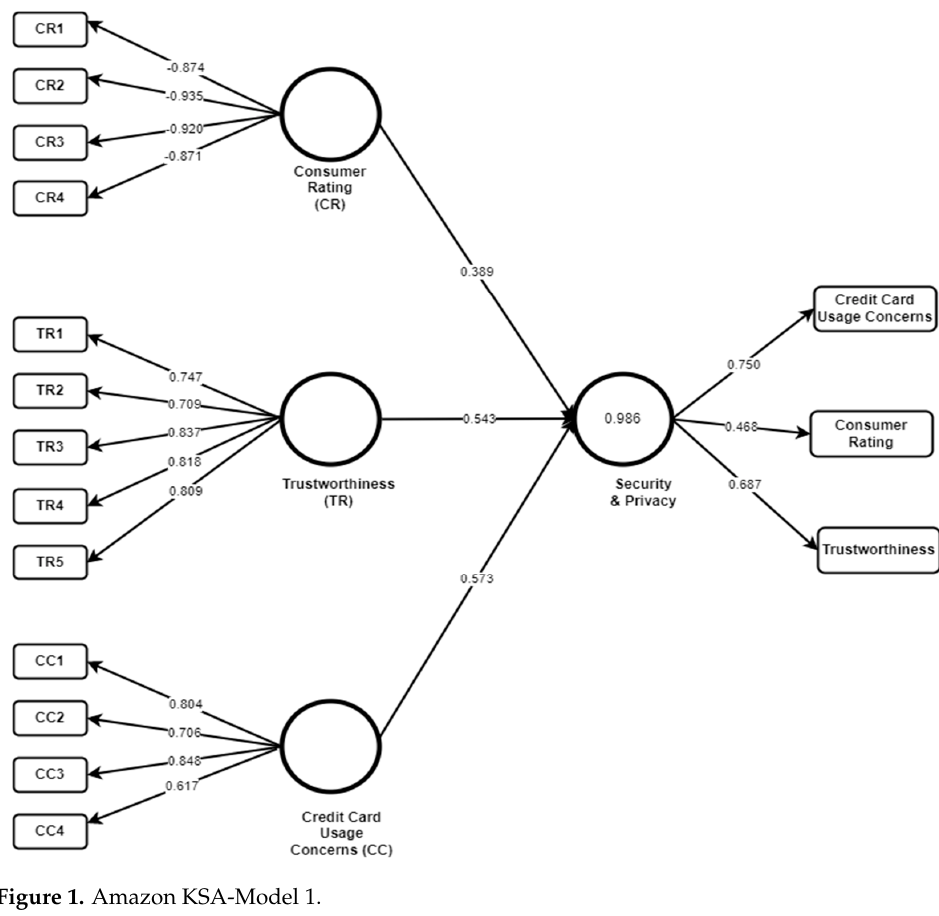
Figure 1. Amazon KSA-Model 1.